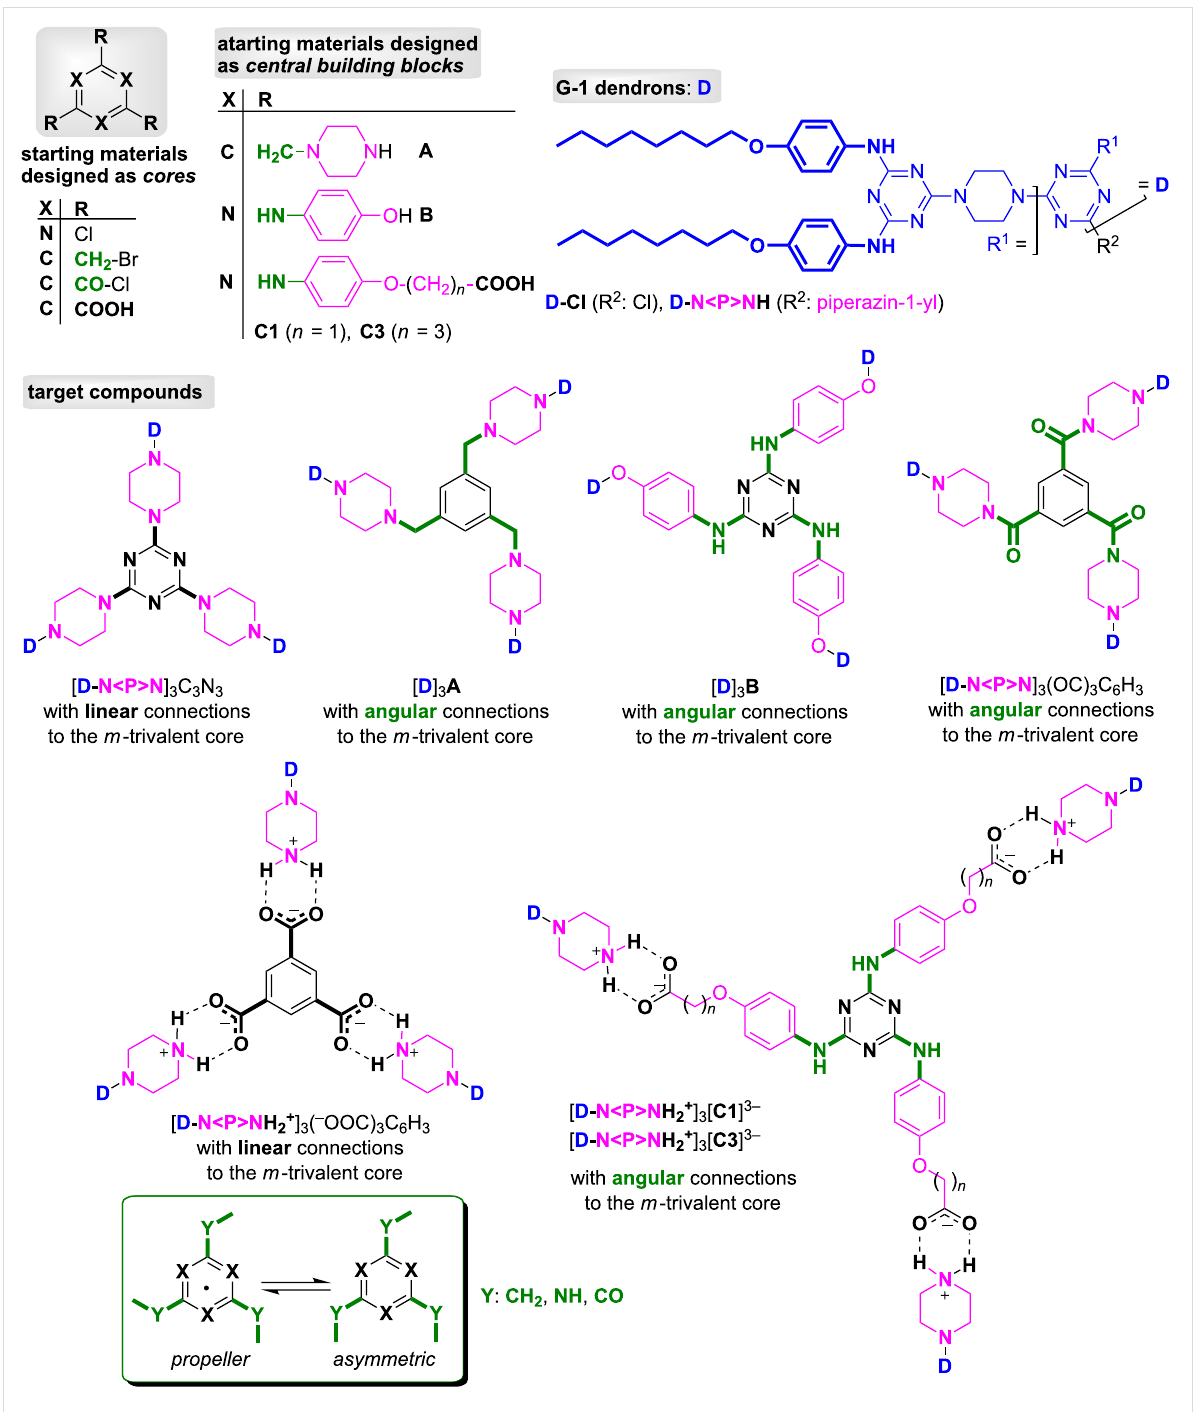
Figure 1: The key elements for design and construction of the targeted G-2 dendrimers.